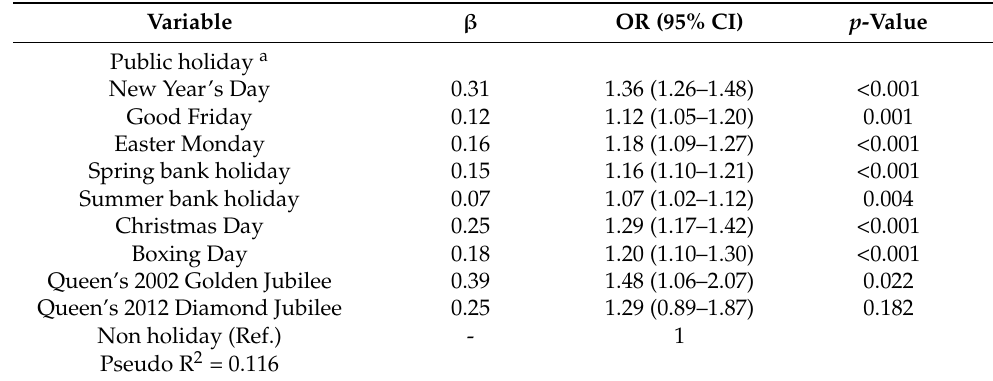
Table 5. Multiple logistic regression results of factors associated with KSIs by different type of holiday (data based on UK STATS19 1990–2017)